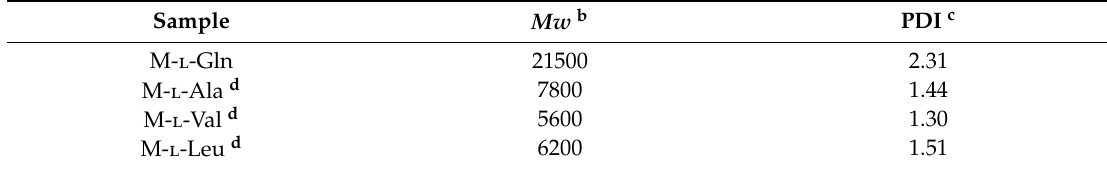
Table 1. Molecular weights of PAACs by SEC. a